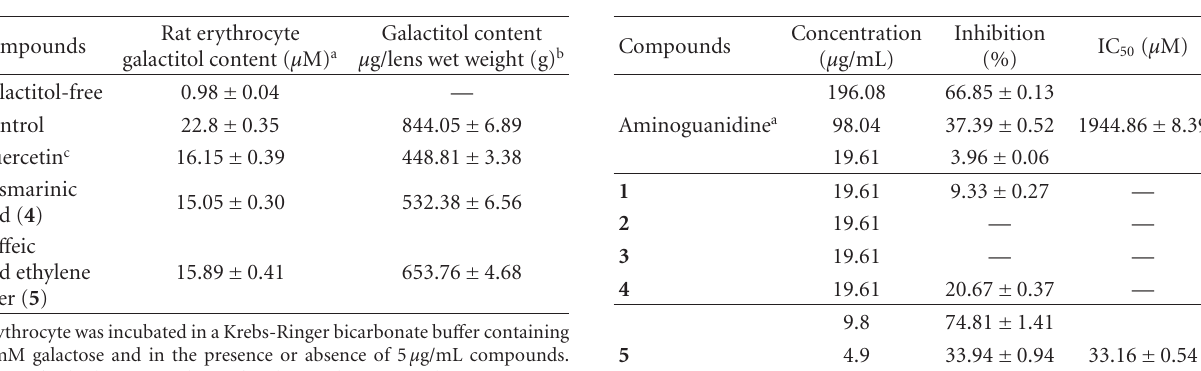
Table 5: Inhibitory e ff ects of the compounds isolated from the P. vulgaris L. on advanced glycation end products (AGEs).